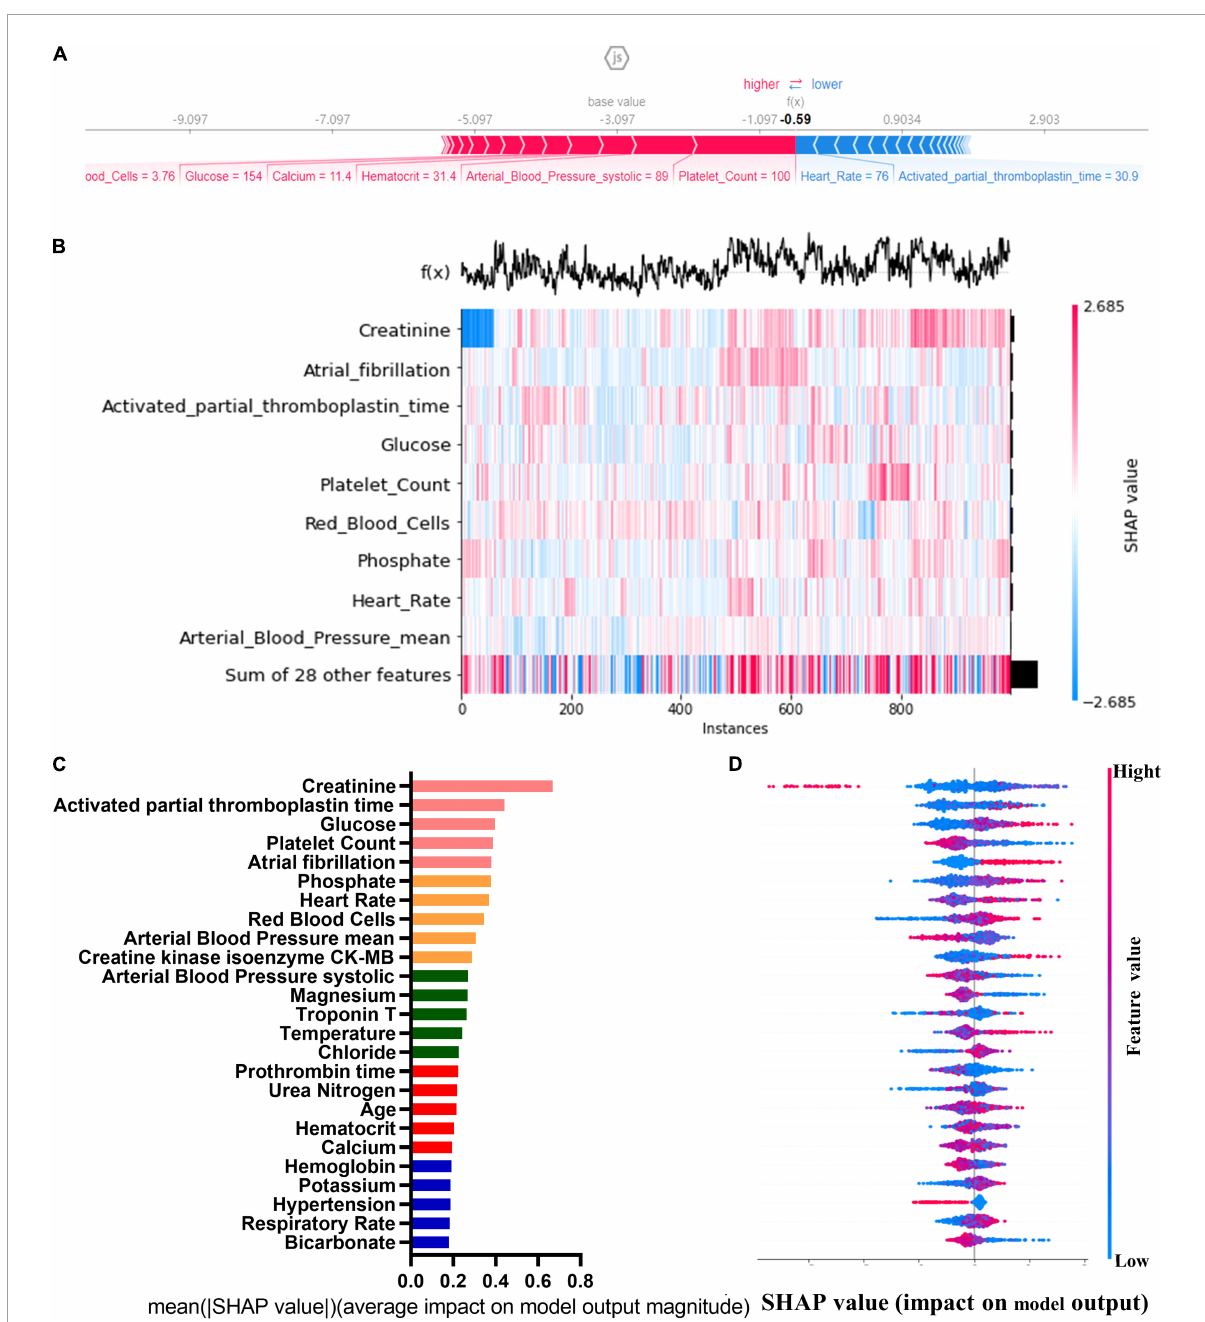
FIGURE2 Single-sample feature impact map (A) ; heat map of feature distribution under sample clustering (B) ; histogram of feature importance (C) ; scatter plot of feature density (D) .